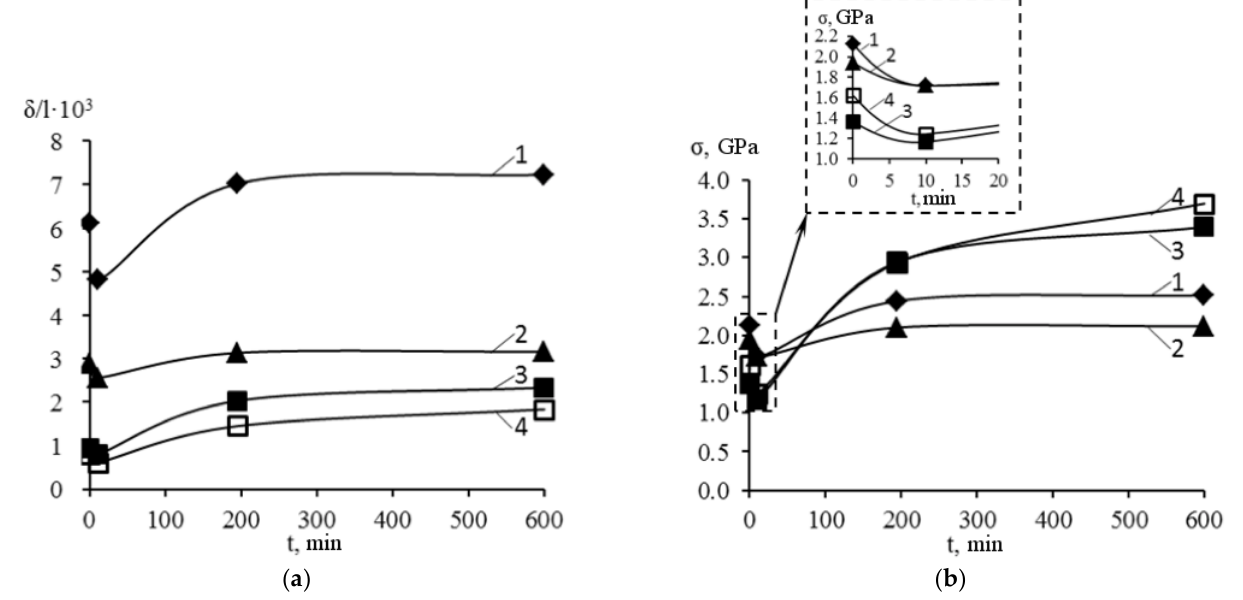
Figure 11. Changes in average reduced normal curvature ( a ) and surface layer stresses ( b ) of 20Kh13 steel samples with different types of surface modification as a result of combined action of surface modification and droplet impact of different duration (at S imp = 250 m/s, d k = 150 μ m): 1—20Kh13 with nitriding (type III); 2—20Kh13 with nitriding (type II); 3—20Kh13 with nitriding (type I); 4—20Kh13 with Cr–CrC coating. Table 4. Results of determining stresses in the surface layer of 20Kh13 steel caused by surface modification and combined action of surface modification and droplet impact of different duration (at S imp = 250 m/s, d k = 150 µ